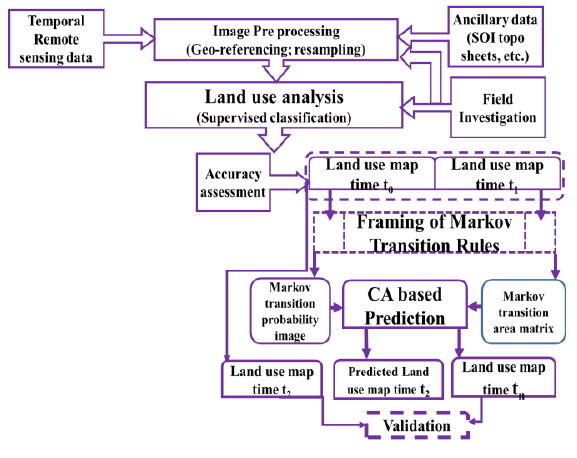
Figure 1. Study area-Karwar taluk.